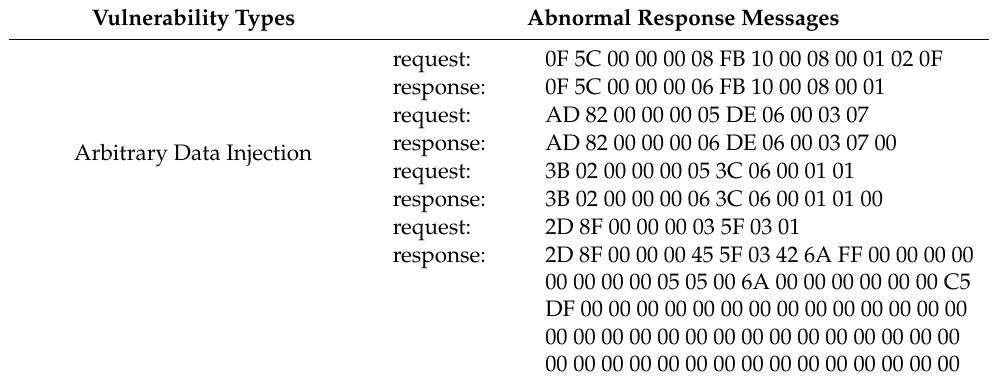
Table A3. All the abnormal response messages that cause the arbitrary data injection